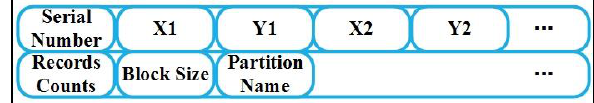
Figure 2. Global index structure